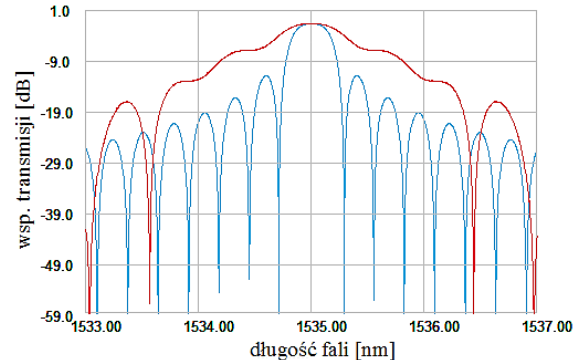
Fig. 22. Comparison of Bragg fiber gratings spectral characteristics without apodization – blue line and apodized sine function for wsp. X = 1 and Y = 3 – red line.